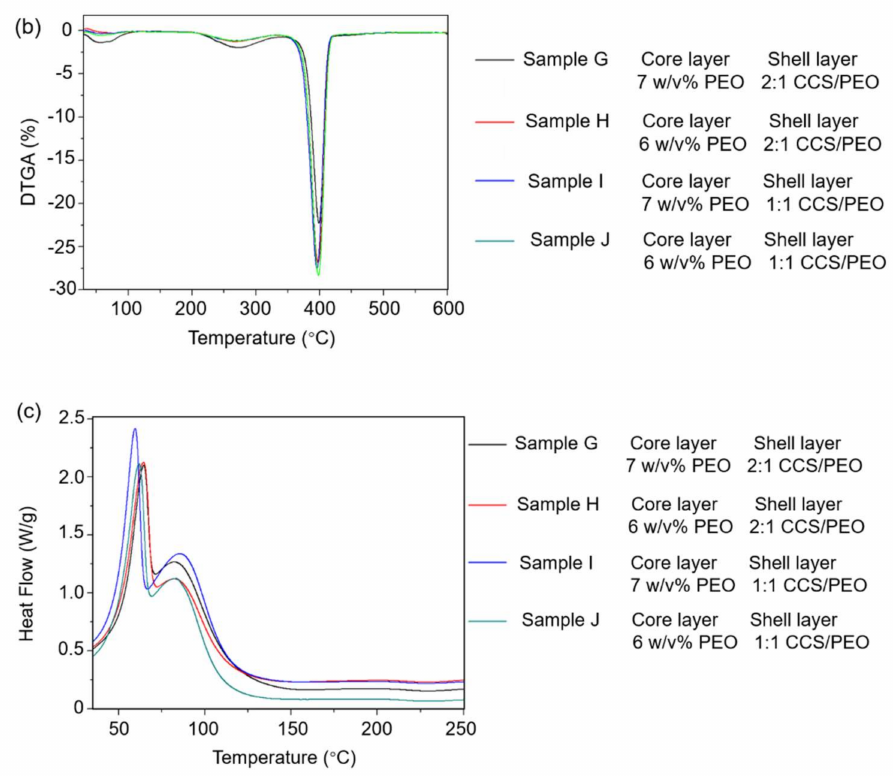
Figure 5. ( a ) TGA, ( b ) DTGA, and ( c ) DSC of nanofibers via co-axial needle centrifugal